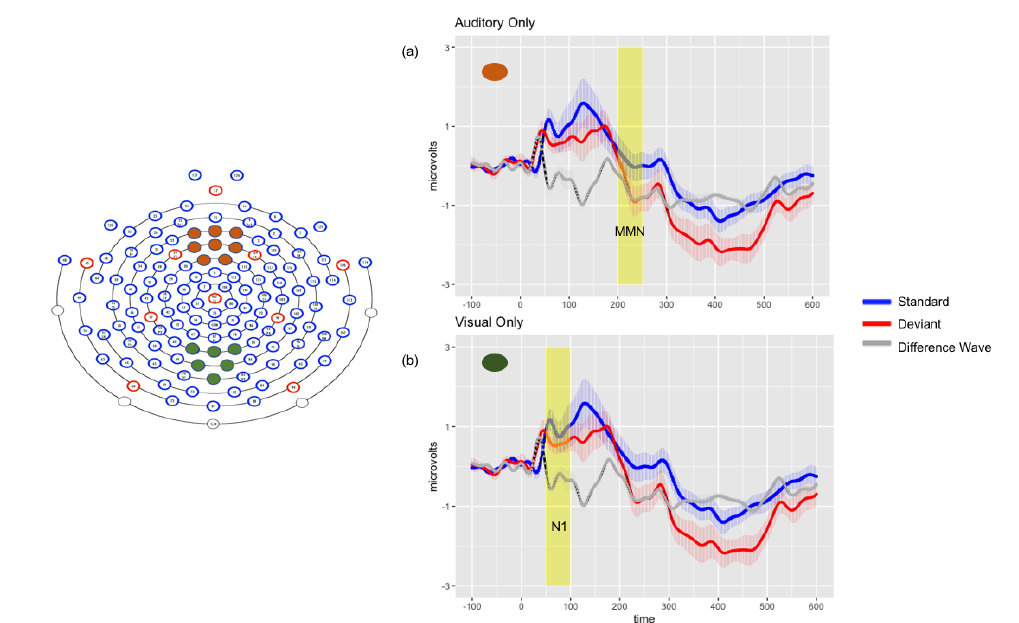
Figure 2 . Left: Electrode montages for auditory only (orange) and visual only (green) grand average waveforms. Right: Grand average waveforms for auditory only (Panel a ) and visual only (Panel b ) conditions. Solid lines represent the average response in microvolts across time in milliseconds, shaded lines represent the standard error of the means at each time point, and shaded rectangle represents time window of significance.